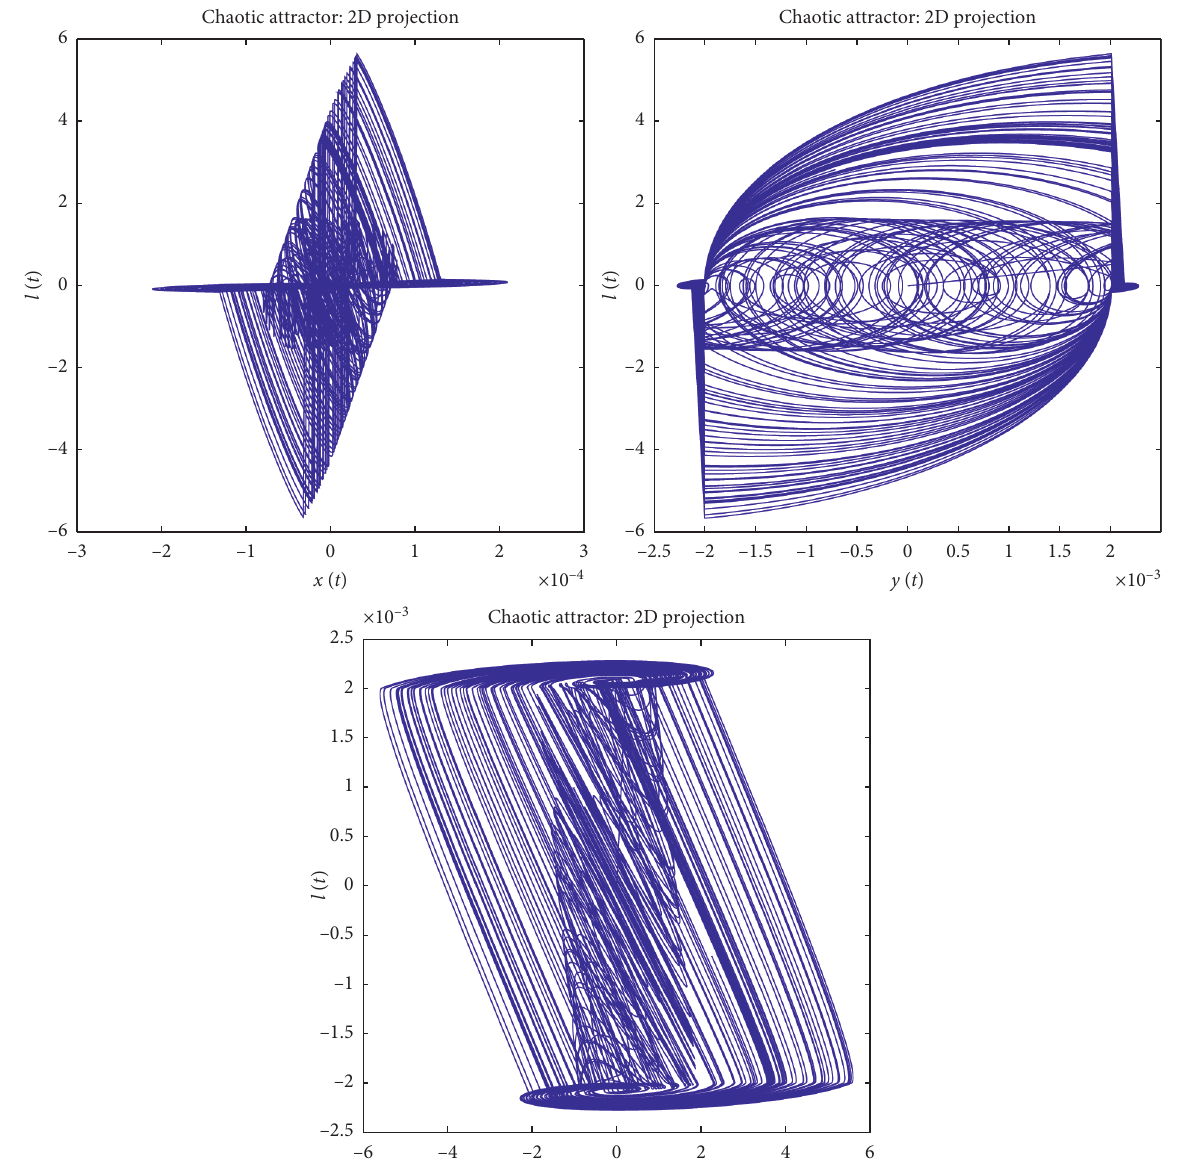
Figure 7: Chaotic attractor in the phase diagram based on the encryption